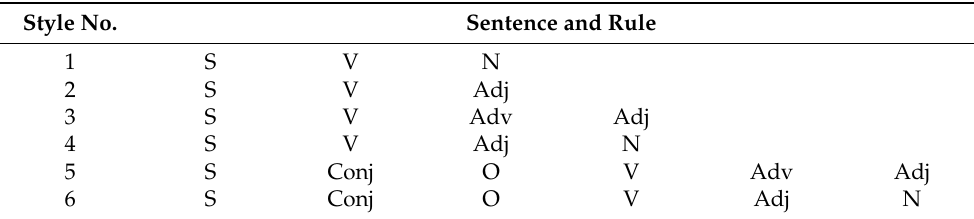
Table 1. Use to Make Sentences and